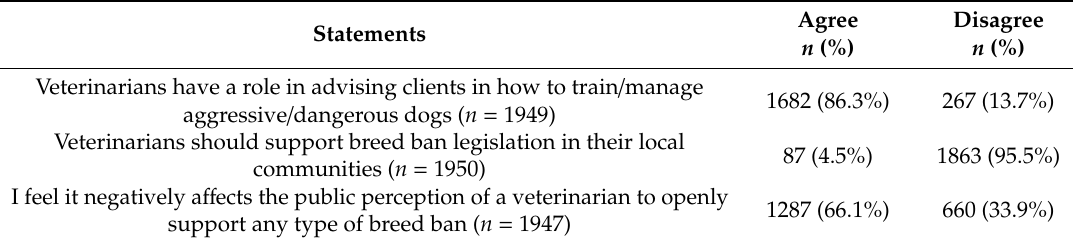
Table 5. Perceptions of veterinary involvement with breed bans.